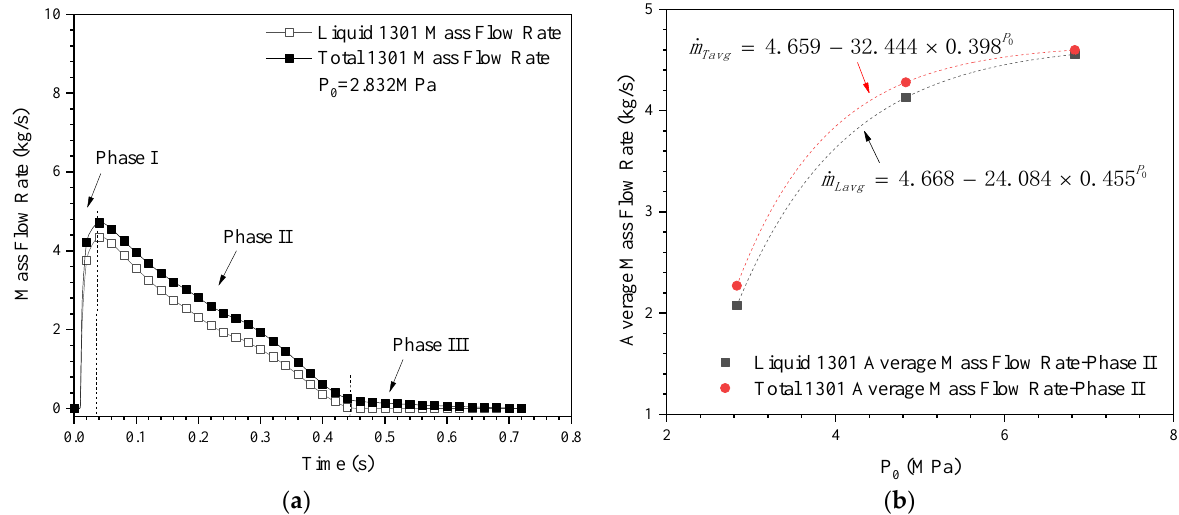
Figure 10. Comparison of mass flow rate of the extinguishing agent: ( a ) variation of liquid and total mass flow rates; ( b ) variation of average mass flow rate with the filling pressure.